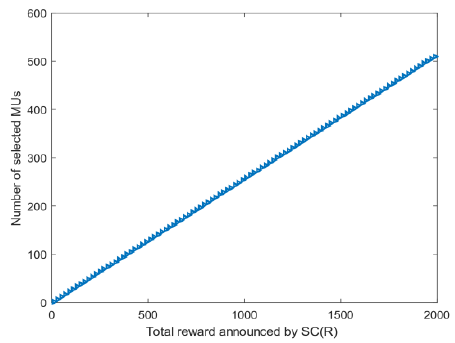
Figure 3. Relationship between the optimal number of MUs and total reward.